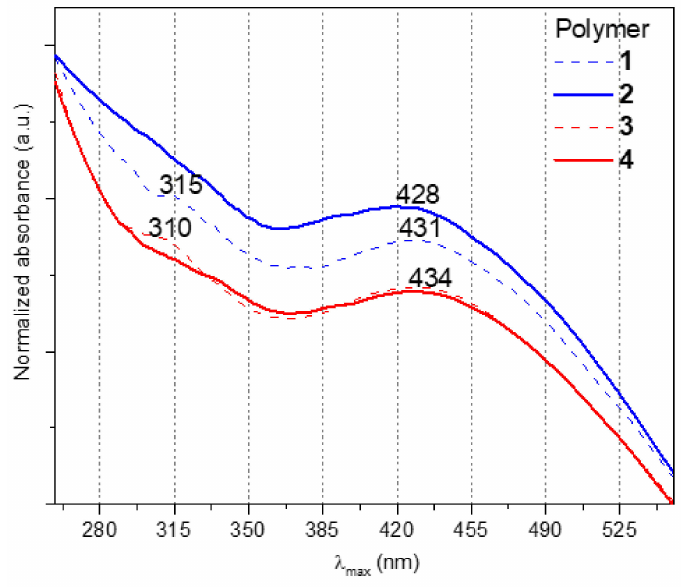
Figure 2. UV-Vis spectra of polymers 1 – 4 registered using DMSO as